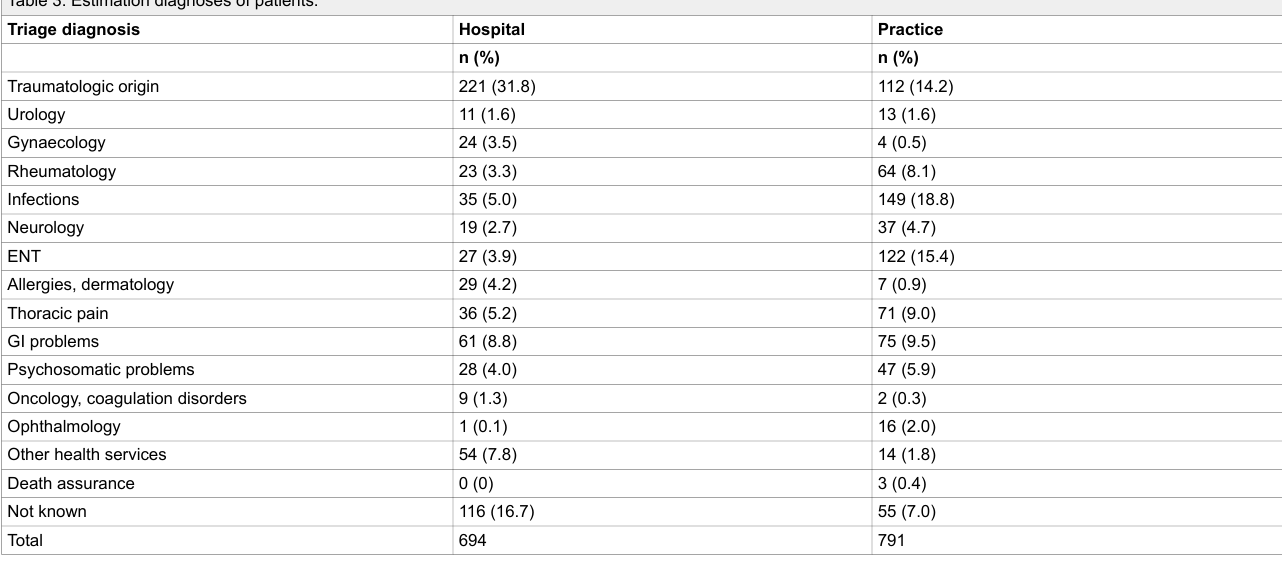
Table 3: Estimation diagnoses of patients.